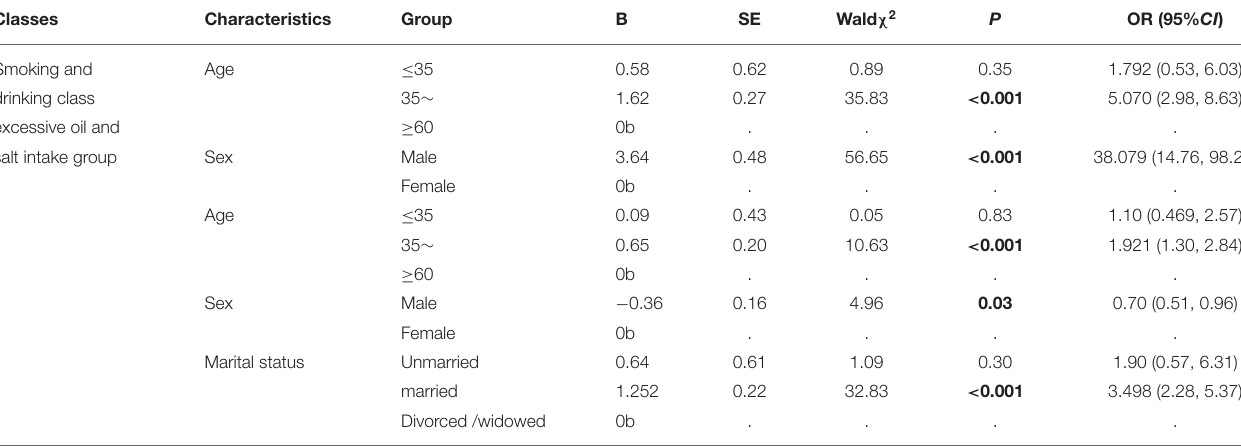
TABLE 2 | Multiple logistic regression analysis of potential classes of health behaviors. Classes